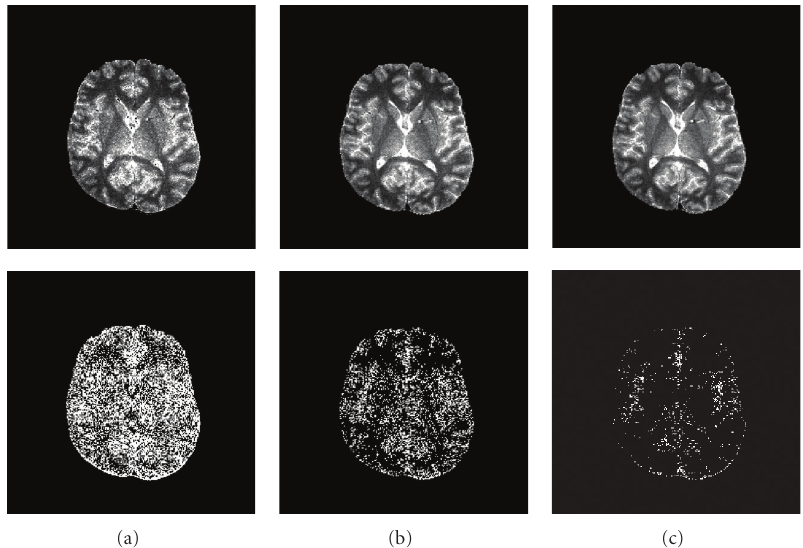
Figure 7: The T 1 -Maps generated by (a) 2 (b) 6 and (c) 10 flip angles on the top row, and their corresponding error maps on the second row.